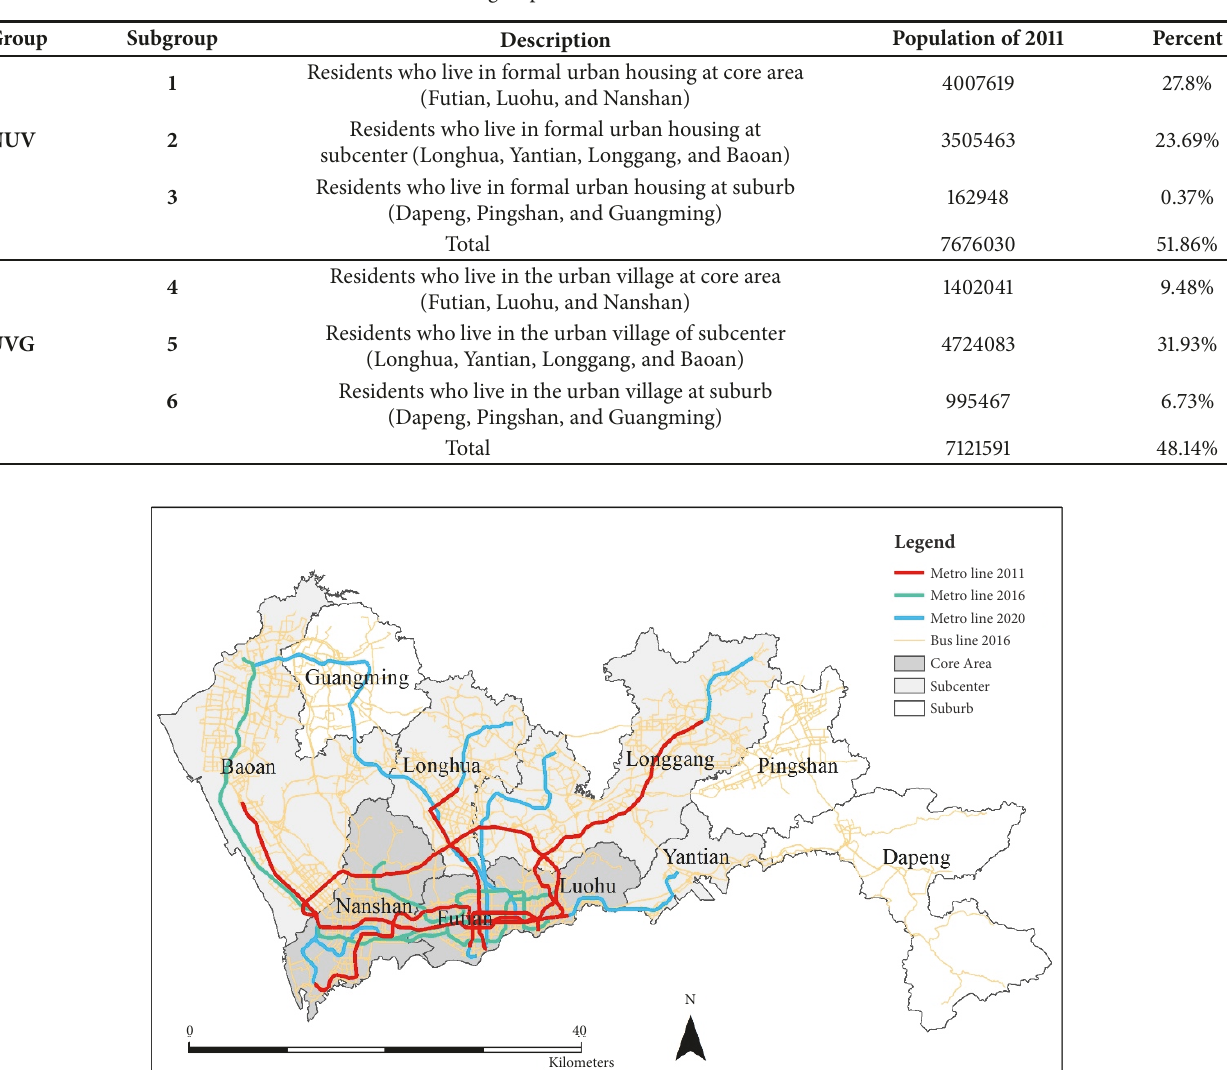
Figure 2: Maps of the transit network in three